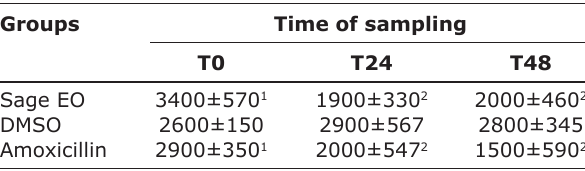
Table-1: Effects of intramammary infusion of sage EO on milk somatic cell count (×10 3 cells/ml) in Awassi sheep affected with subclinical mastitis